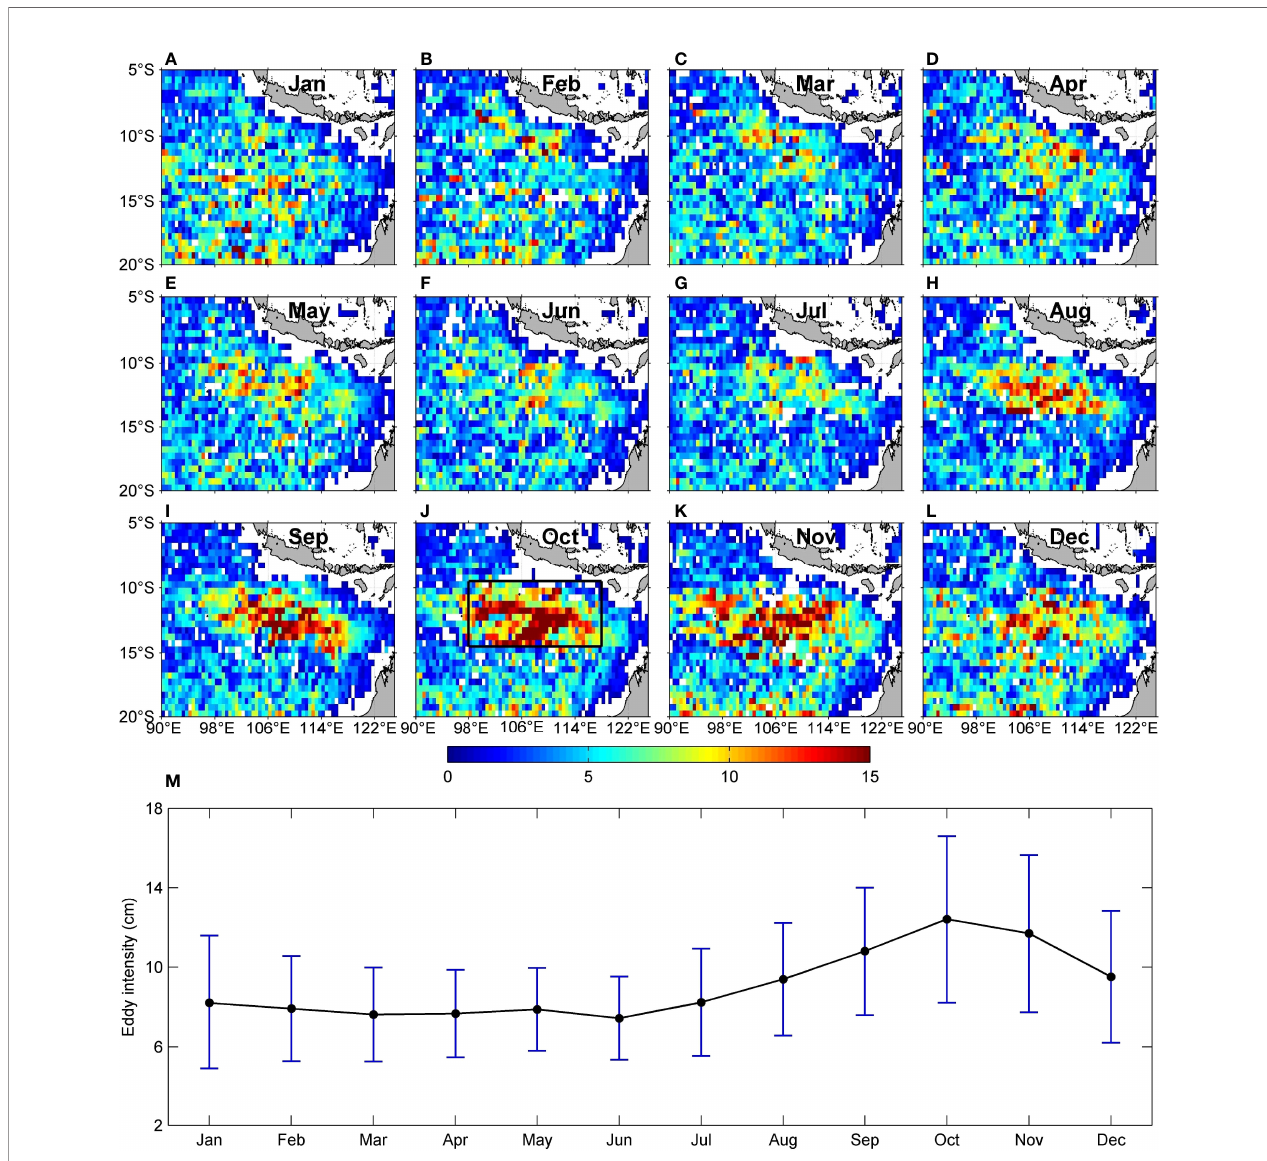
FIGURE 2 | (A – L) Spatial distribution of eddy intensity (unit: cm) of each calendar month, and (M) seasonal variation of eddy intensity averaged in the black rectangular box (9.5° – 14.5°S, 98° – 118°E) shown in (J) . The error bars in (M) show the standard deviation of eddy intensity in every